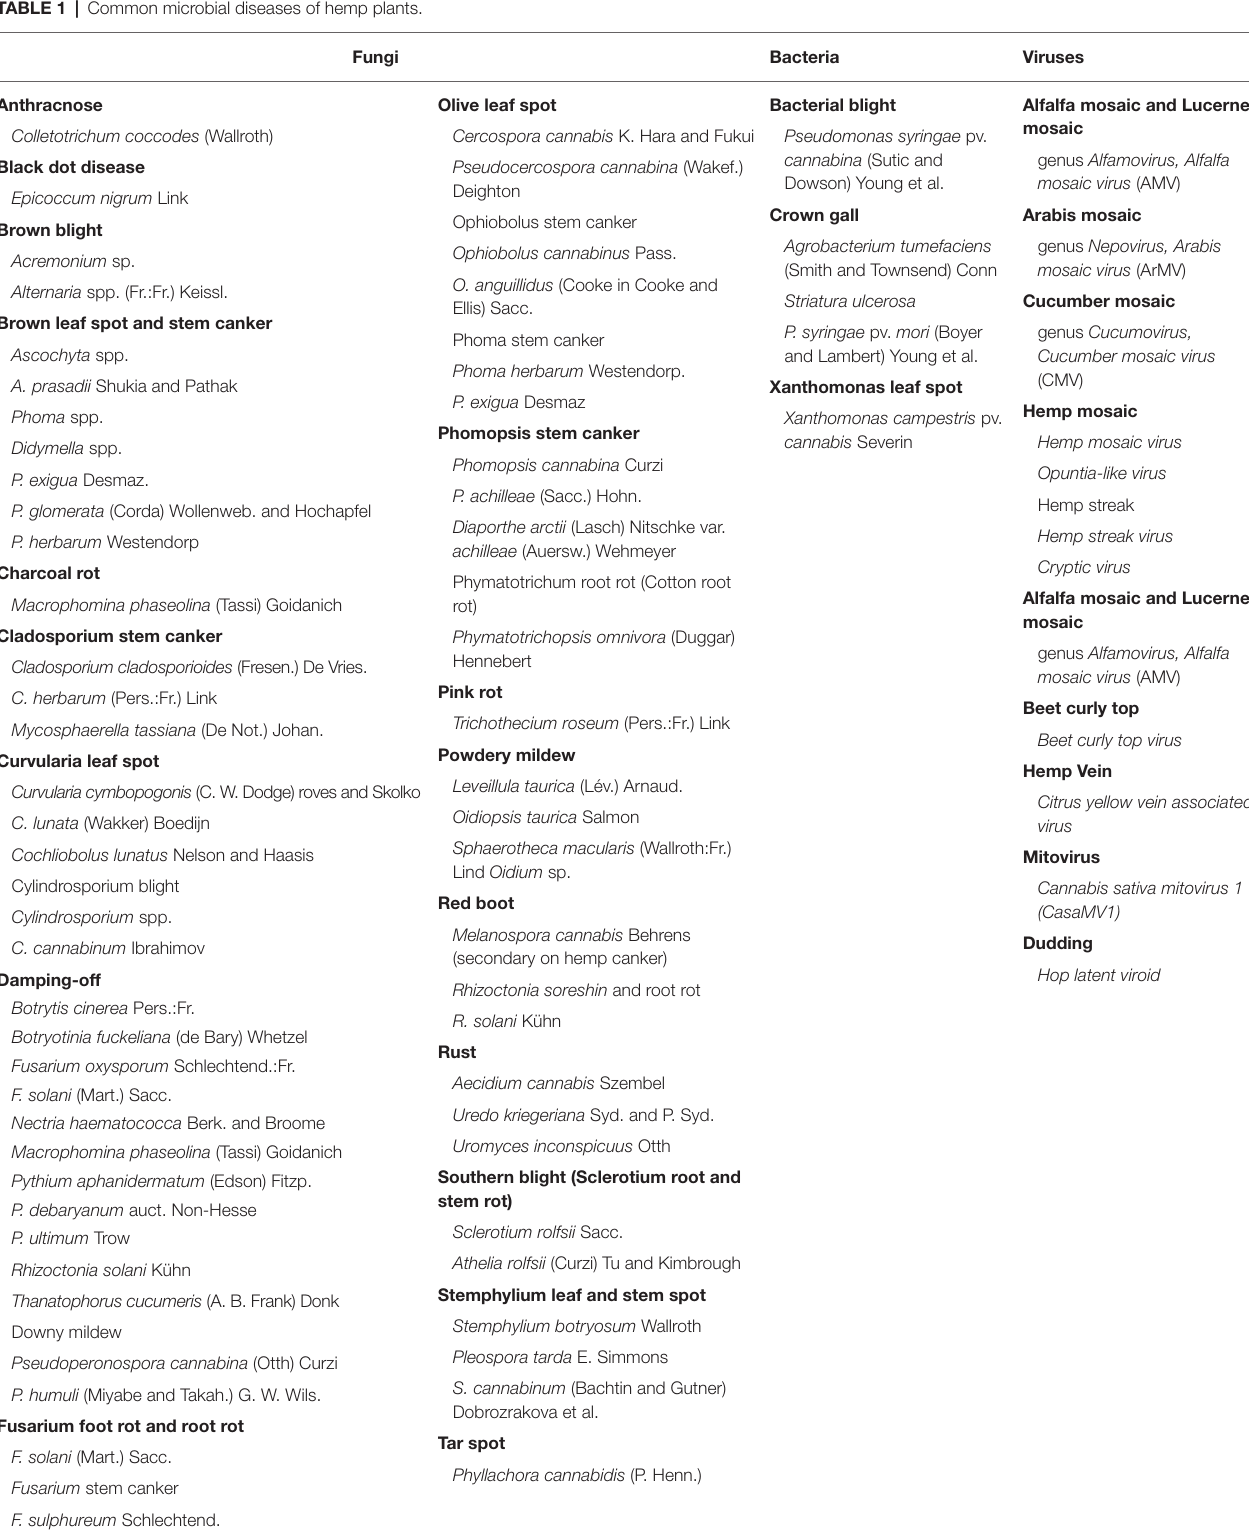
TABLE 1 | Common microbial diseases of hemp